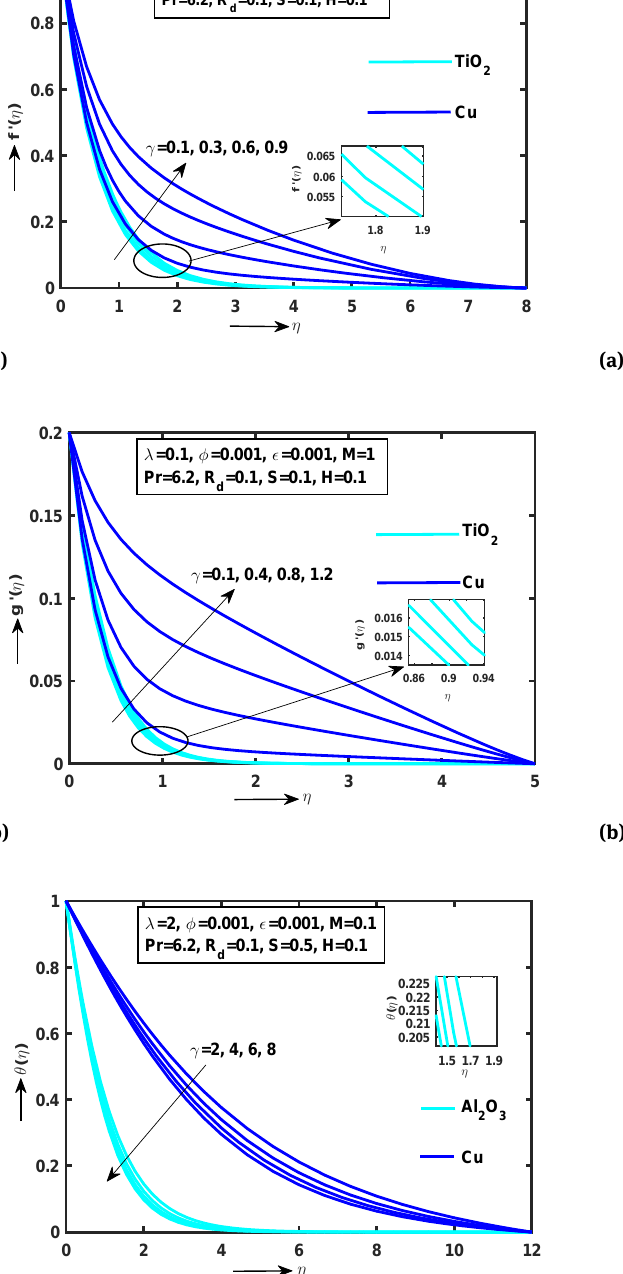
Figure 4: (a) Significance of λ on f (cid:48) ( η ) (b) Significance of λ on g (cid:48) ( η ) (c) Significance of λ on θ ( η